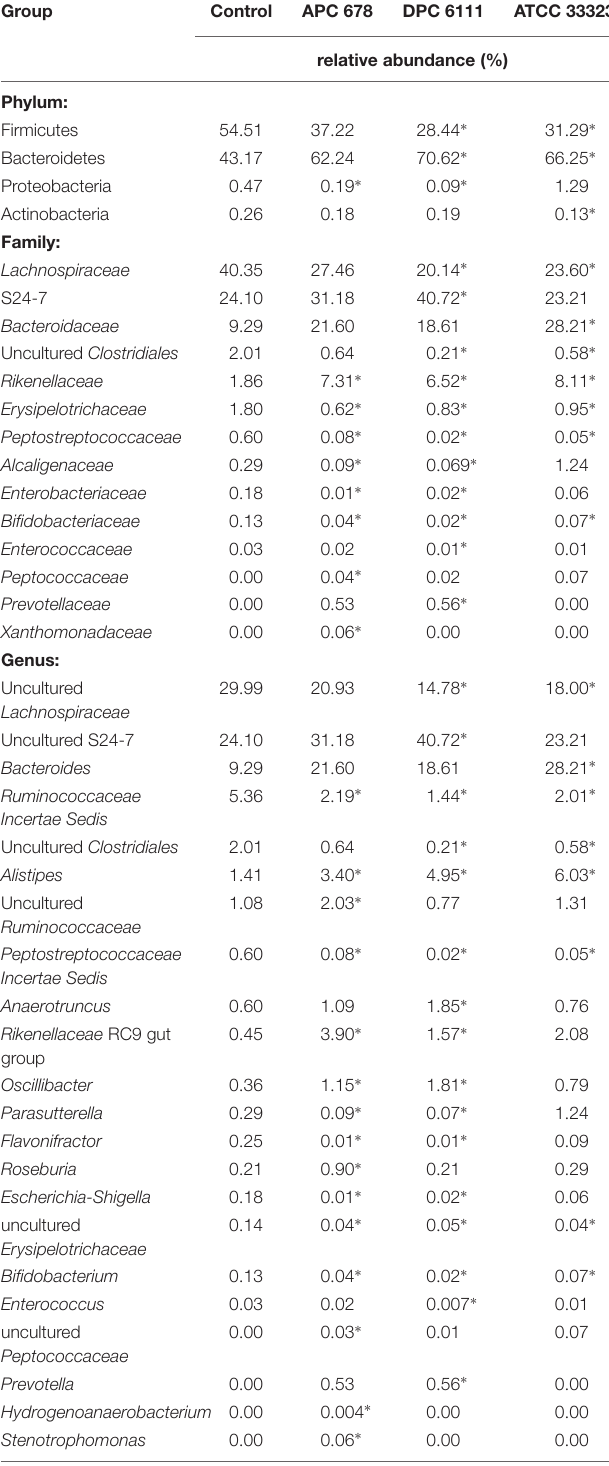
TABLE 4 | Relative abundance (%) at bacterial phylum, family and genus level in the cecum at Day 7 of the control and test mice ( Lactobacillus gasseri APC